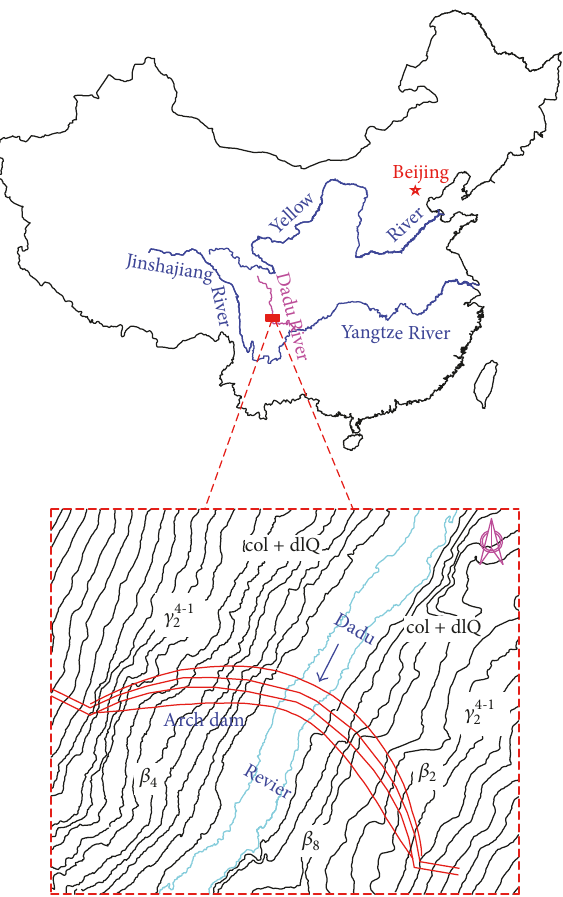
Figure 1: Sampling location: Dagangshan hydropower